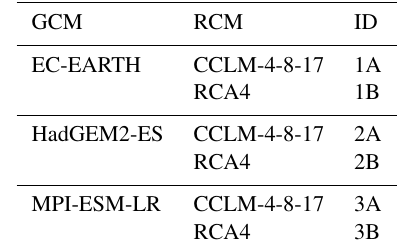
Table 1. Global and regional climate models used in the present study.